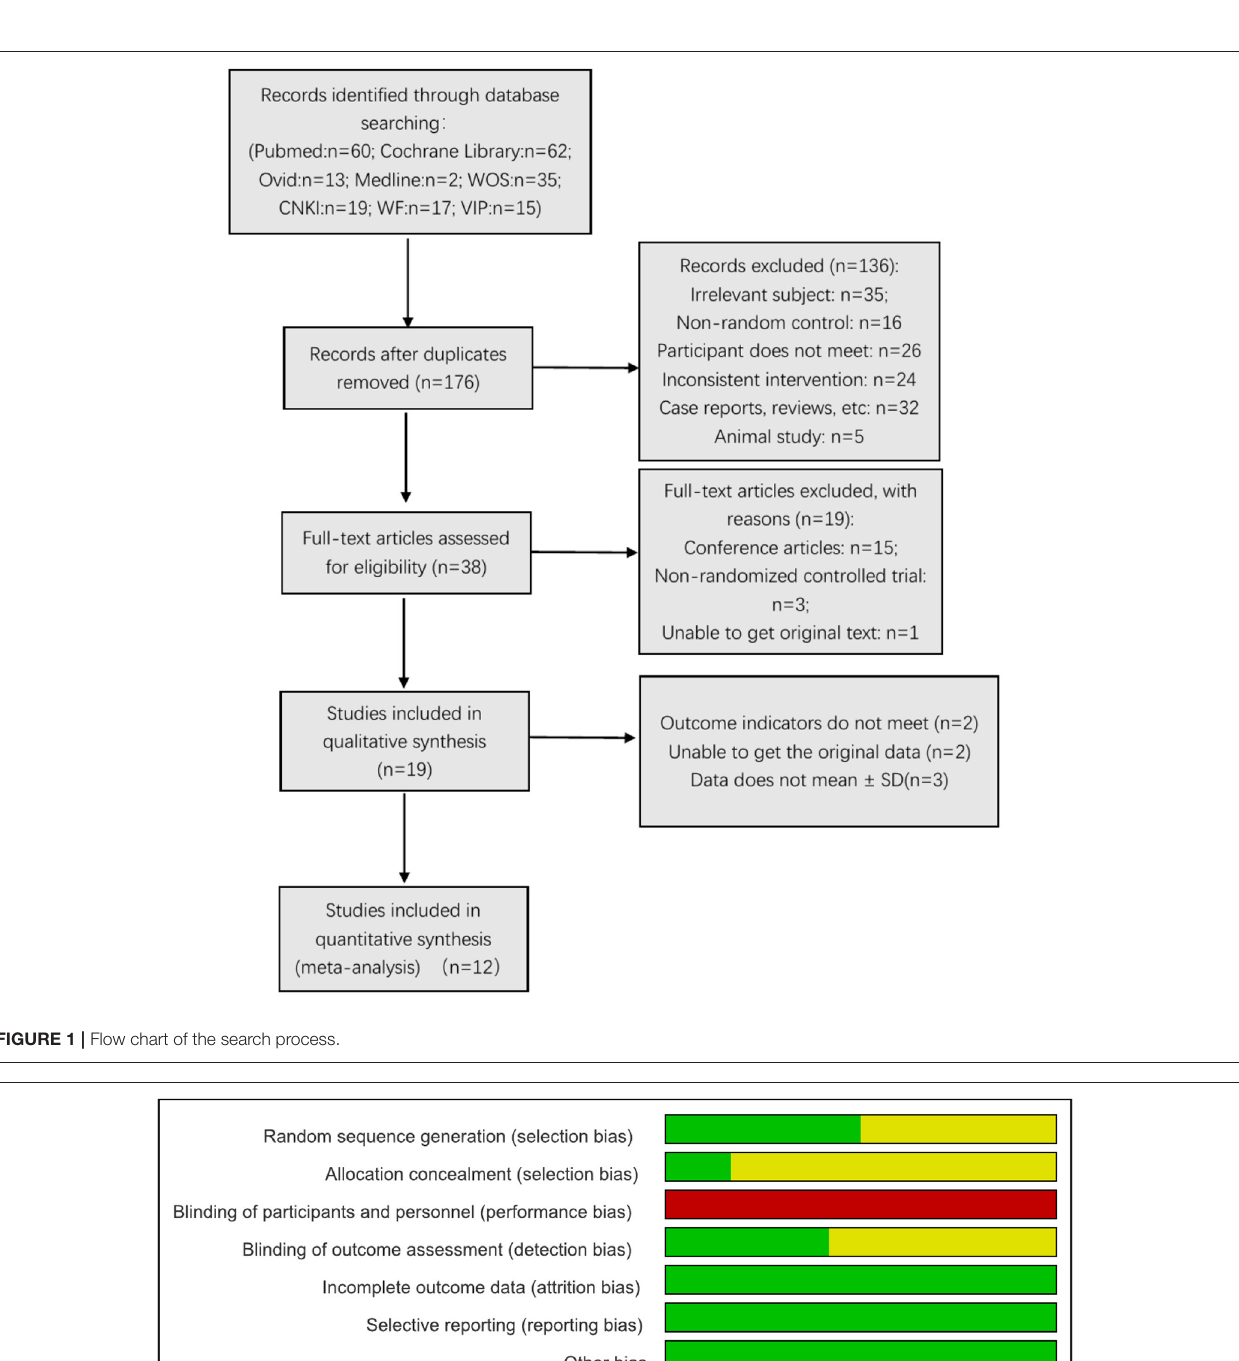
FIGURE 2 | Risk of bias